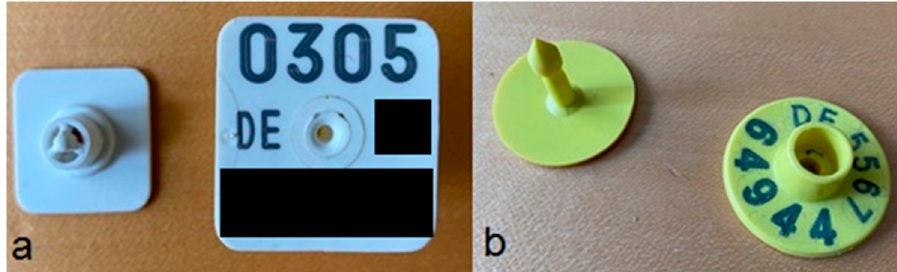
Figure 1. Analogue ( a ) and electronic ( b ) ear tags used in the trial. Farm number details are blacked out for data protection reasons.